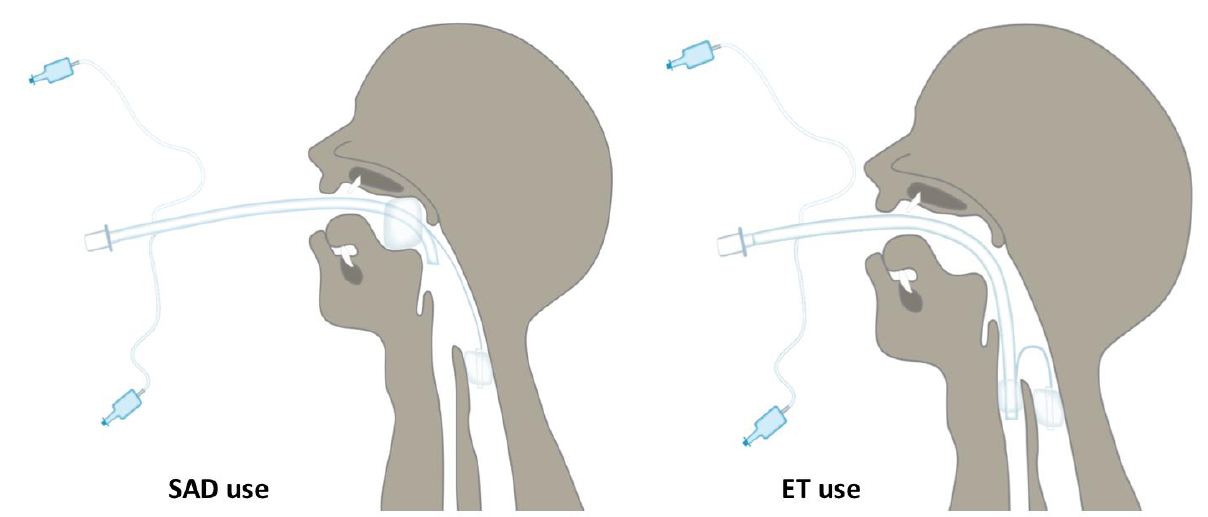
Figure 4. Spritztube in position. Schematic representation of Spritztube in position; on left the extraglottic use (proximal cuff inflated in oropharynx and distal cuff inflated in upper oesophagus). On the right, endotracheal tube use (proximal cuff inflated in trachea, distal cuff left in place in the upper oesophagus).